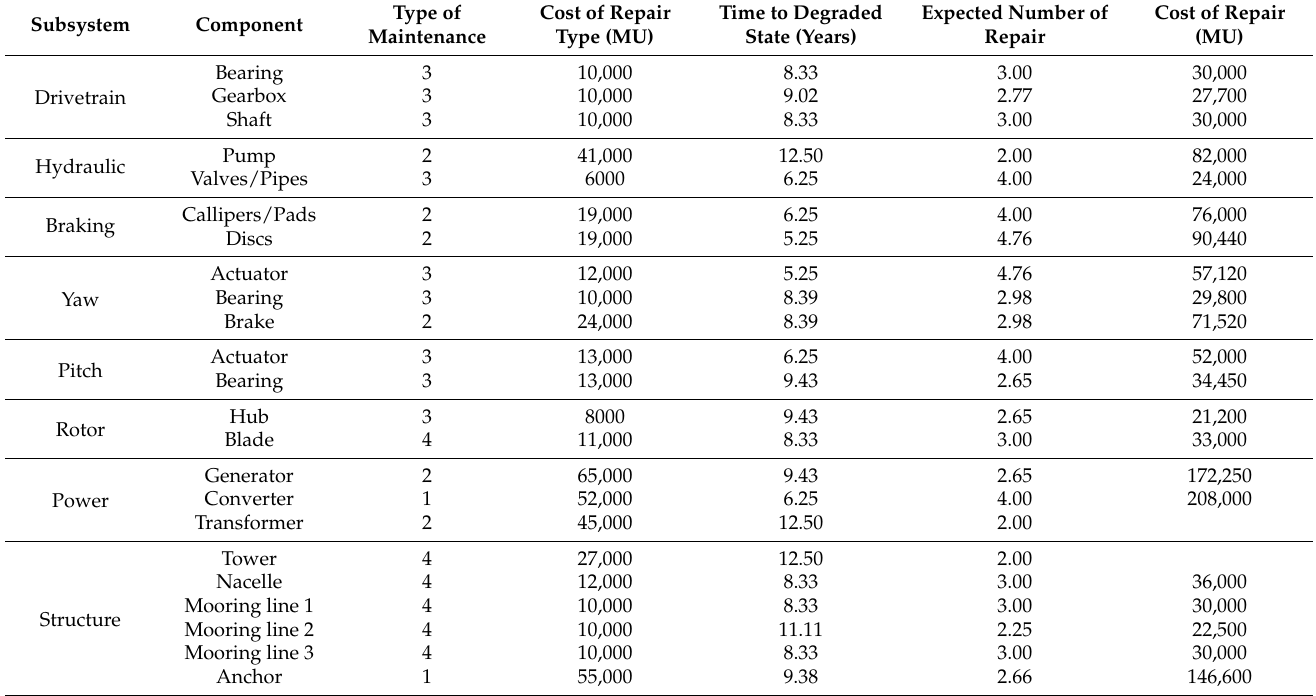
Table 4. Table 4. Expected number of repairs and associated costs.